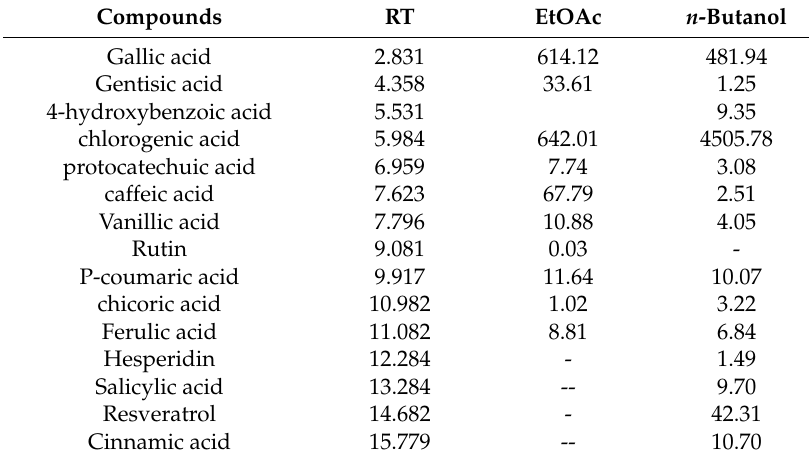
Table 3. Composition of ethyl acetate and n -butanol extracts determined by HPLC-TOF/MS (mg of phenolic compound/kg